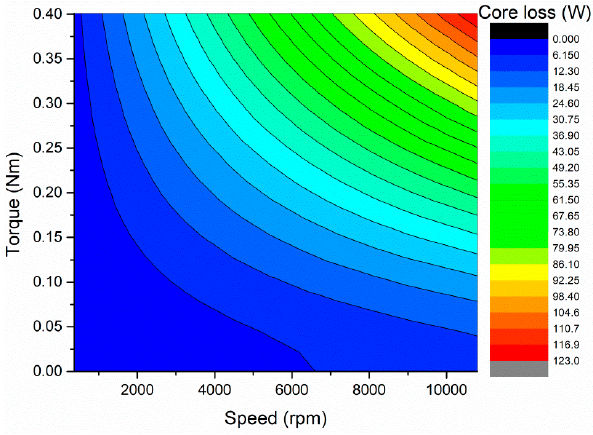
Figure 11. Core loss with the variation of torque and speed.